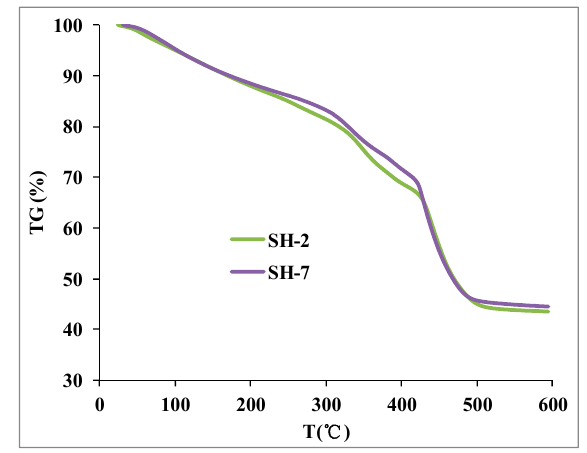
Figure 7. TGA curves of SH-2 and SH-7 hydrogels.